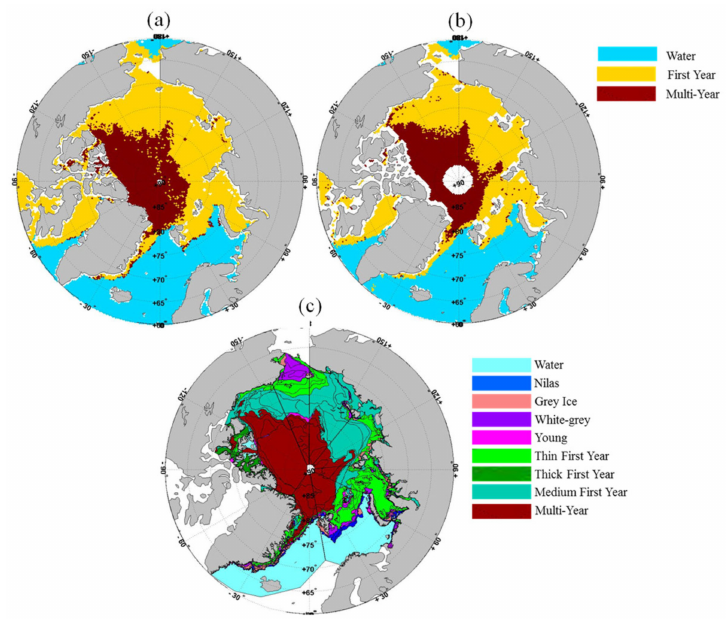
Figure 10. Distribution of MY and FY ice on 7 January 2020 by ( a ) OSI SAF Sea Ice Type product, ( b ) based on δχ 1 = χ 10V − χ 06V using the threshold of 0.001. ( c ) AARI sea ice map on 7 January